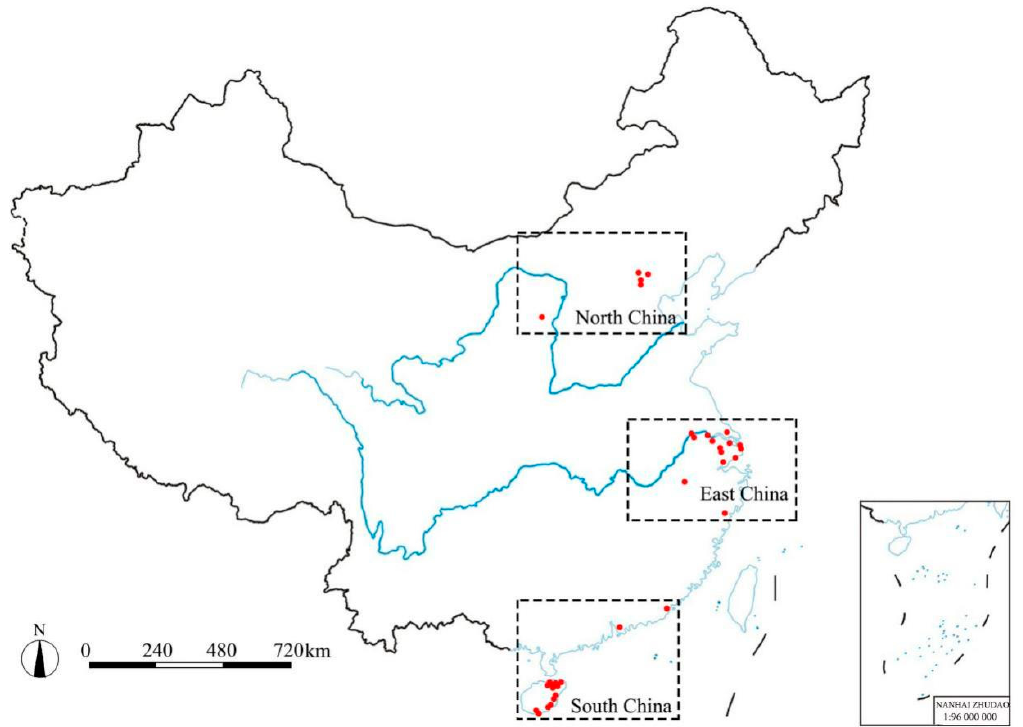
Figure 1. The distributions of the thirty-three sampled golf courses in North, East, and South China.